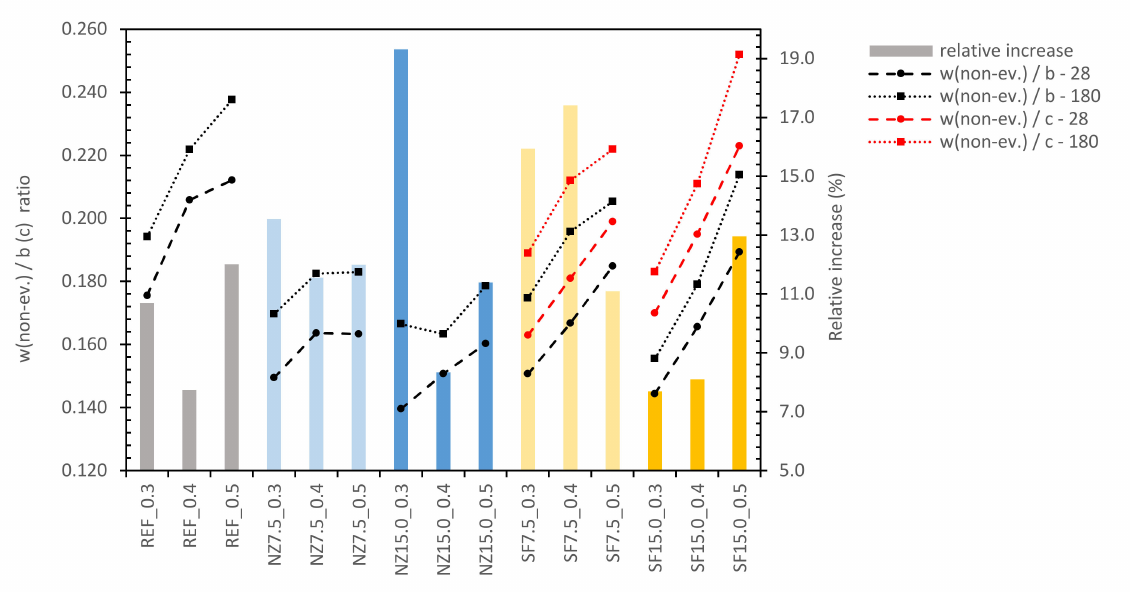
Figure 6. Development of chemically bounded